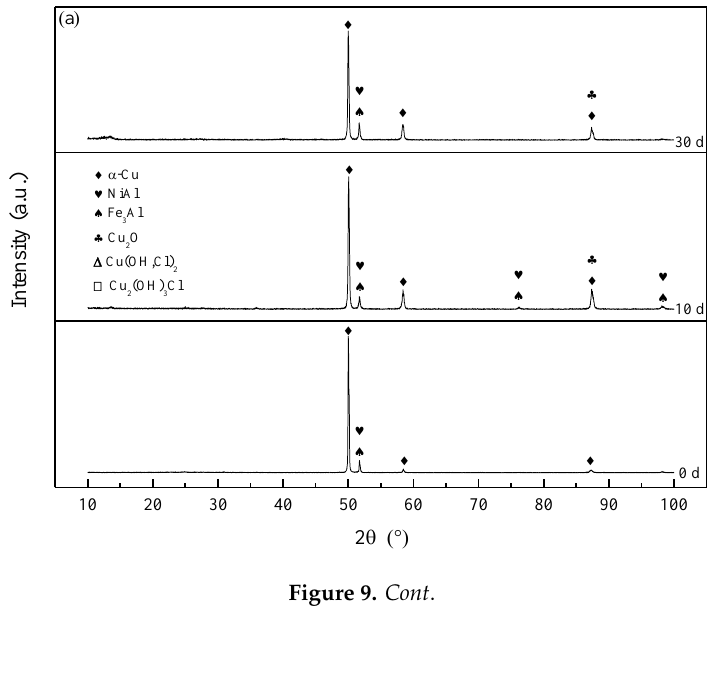
Figure 8. The XRD patterns of S-Defect immersed for different time periods in artificial seawater.